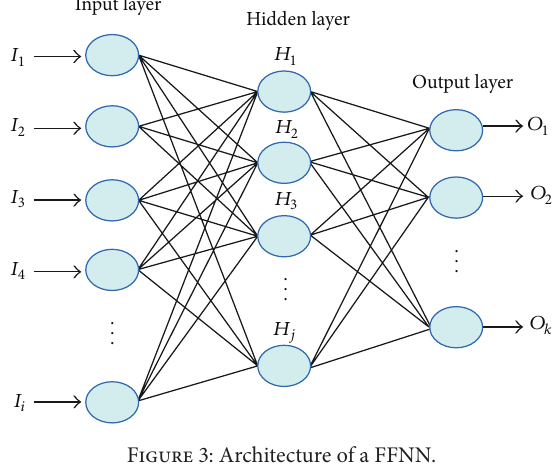
Figure 3: Architecture of a